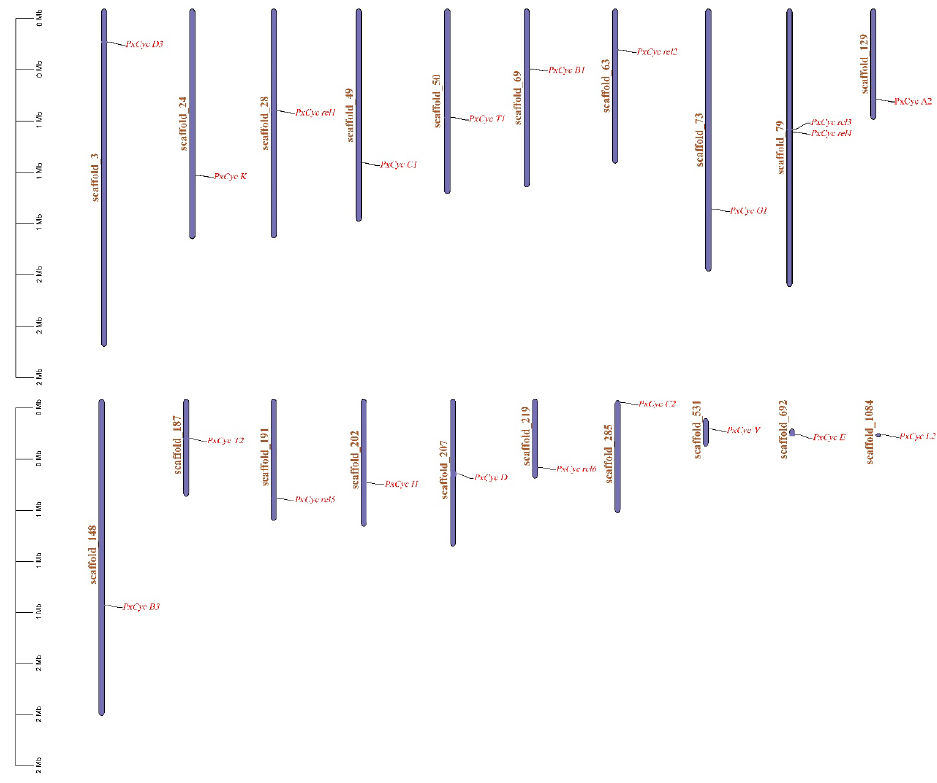
Figure 2. Genomic distribution of the P. xylostella cyclin-like proteins. Most of the scaffolds possessed a single cyclin-like protein except scaffold 79, which possessed two cyclin-like proteins. The evolutionary relationships of the cyclin-like proteins of P. xylostella with three other insects ( B. mori , D. melanogaster, and Apis melifera ) from three different orders (Lepi- doptera, Diptera, and Hymenoptera) were studied by constructing the phylogenetic tree. A total of 22, 34, and 14 genes were identified in B. mori , D. melanogeter, and A. melifera , respectively, which contained multiple isoforms for one gene. We finalized 14,12, and 11 genes of B. mori , D. melanogeter, and A. melifera for phylogenic analysis after removing